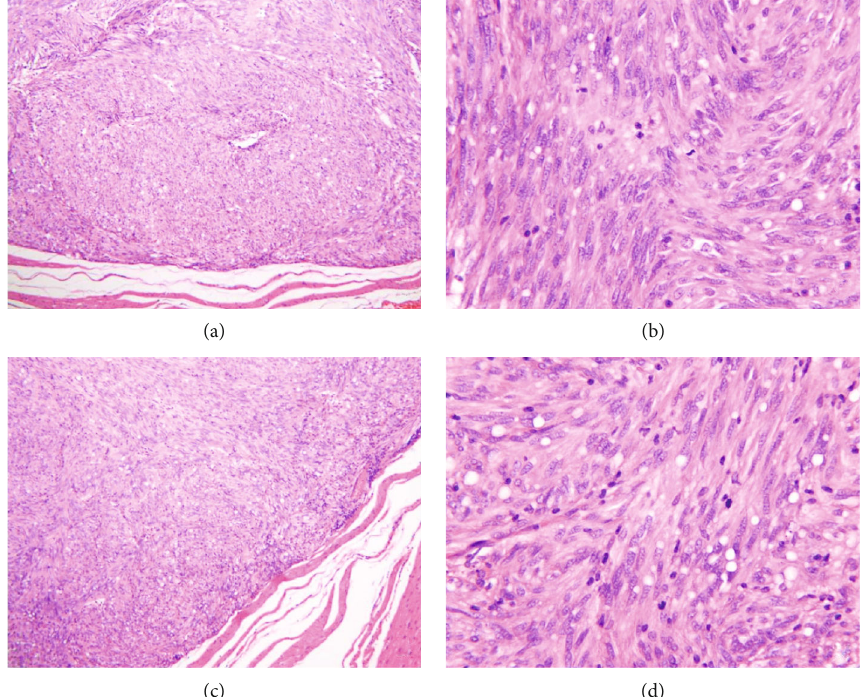
Figure 3: Postoperative pathology con fi rmed the presence of gastric stromal tumor, with complete envelope in all patients. (a, b) Tumor with complete capsule (HE × 100). (c, d) Mitotic counts (HE ×